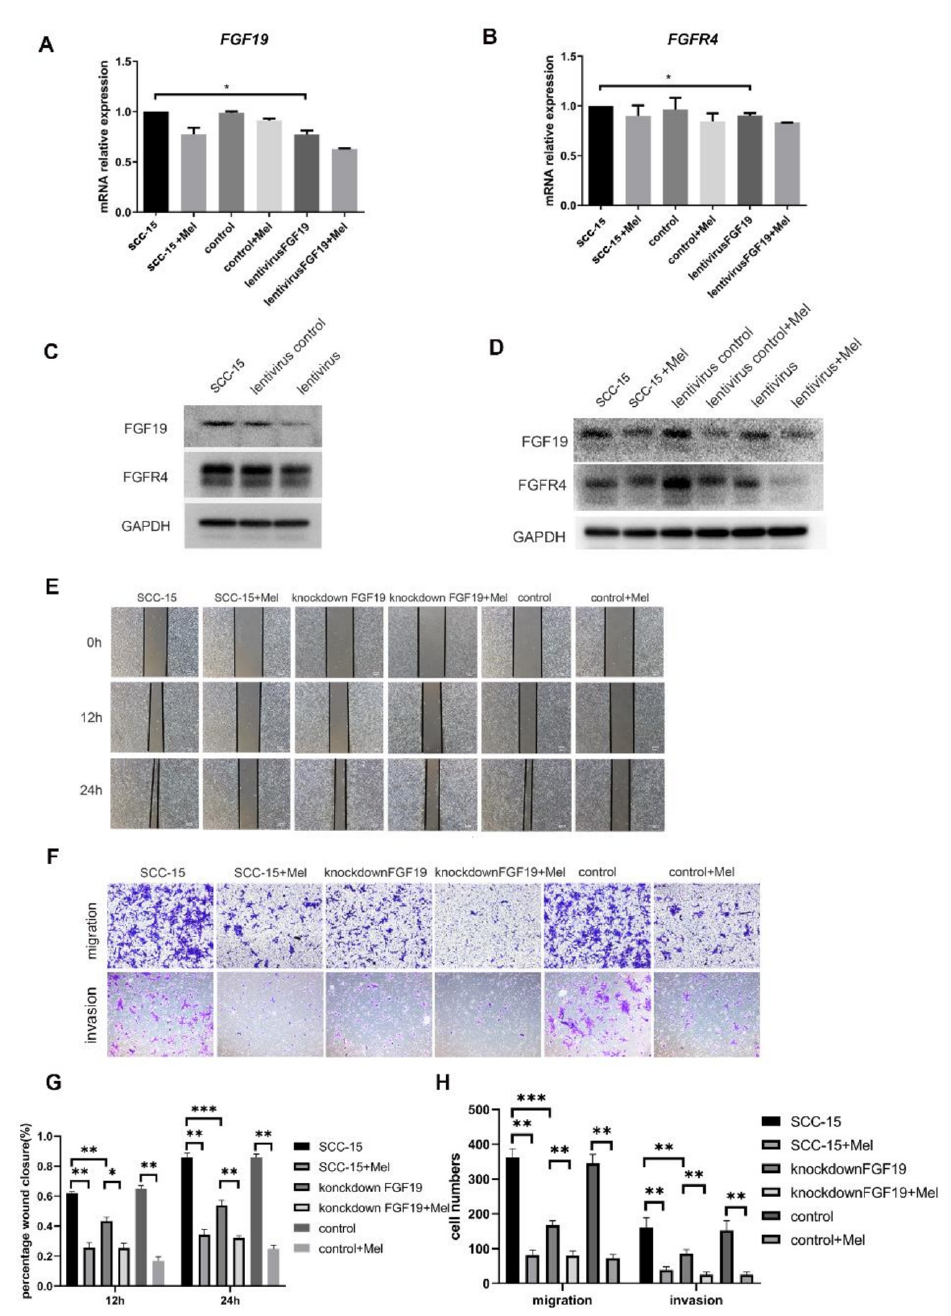
Figure 4. The mRNA and protein expression levels of FGF19/FGFR4 after FGF19 knocking down. The mRNA ( A , B ) and protein expression levels of FGF19/FGFR4 ( C , D ) after hFGF19 knocking down. The invasion and migration ability of cell was determined by trasnwell migration assays at 24 h ( F ), transwell invasion assays at 36 h ( F ) and wound healing at 12 h, 24 h, 36 h ( E ) (Scale bars: ( E , G ), 100 nm). Quantitative data from three independent experiments are shown in the bottom, respectively ( G , H ). * p < 0.05; ** p < 0.01, *** p <